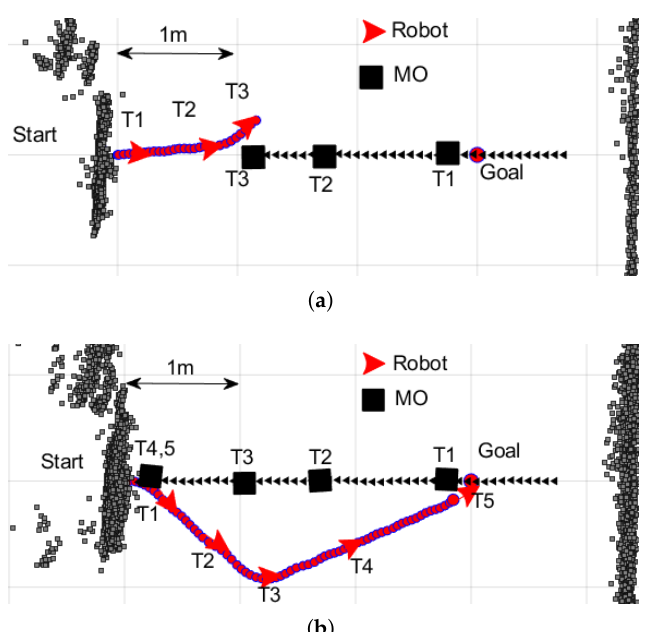
Figure 8. The robot’s paths observed in Experiment 2 with different configurations. The robot’s and obstacle locations at three different time instants are shown as T1–T3. ( a ) Moving obstacle without the new FLC. ( b ) Moving obstacle with the new